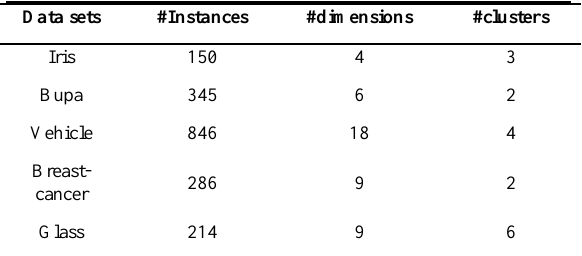
Table 1. Description of selected UCI datasets in terms of number of instances, dimensions, and